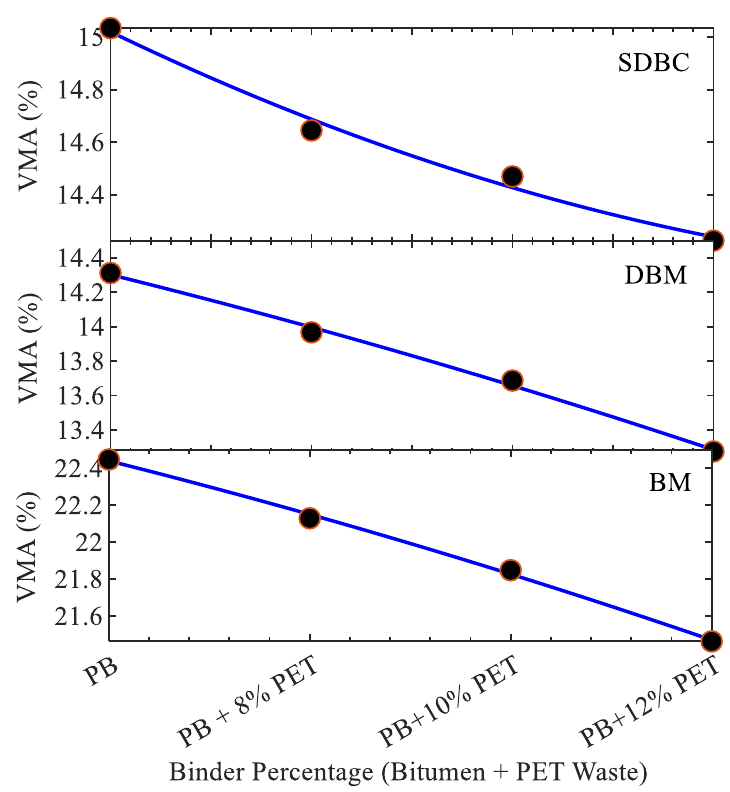
Fig. 29 Relations between voids in mineral aggregates and binder content for modified SDBC, DBM, and BM